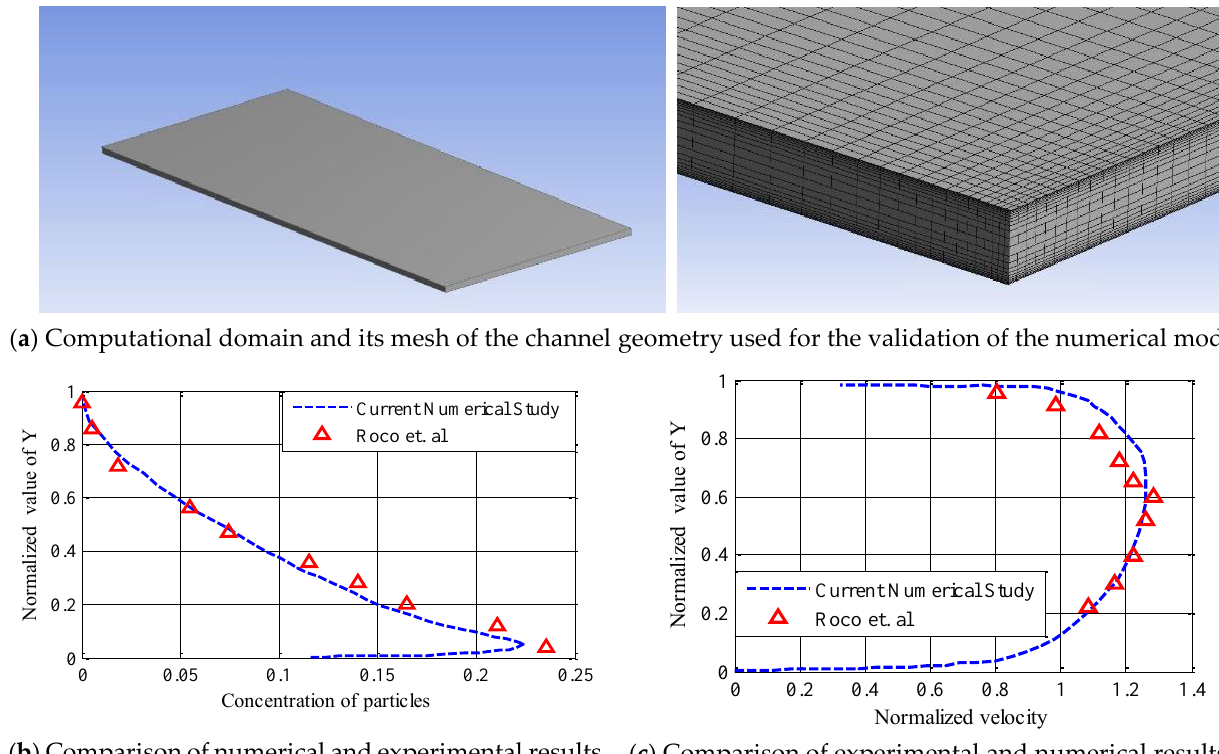
( c ) Comparison of experimental and numerical results of the velocity profile. Figure 8. Validation of the computational model. Figure 8. Validation of the computational